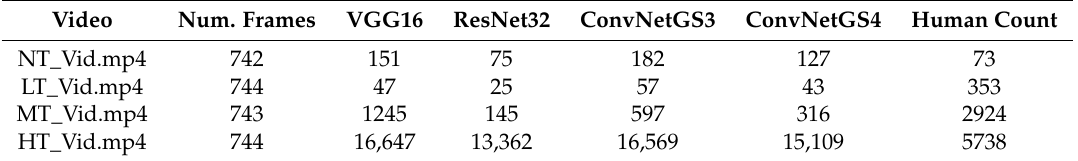
Table 2. Performance of the system on the four evaluation videos: the columns VGG16, ResNet32, ConvNetGS3, and ConvNetGS4 give the bee motion counts returned by the configurations MOG2/VGG16, MOG2/ResNet32, MOG2/ConvNetGS3, and MOG2/ConvNetGS4, respectively; and the last column gives the human bee motion counts for each